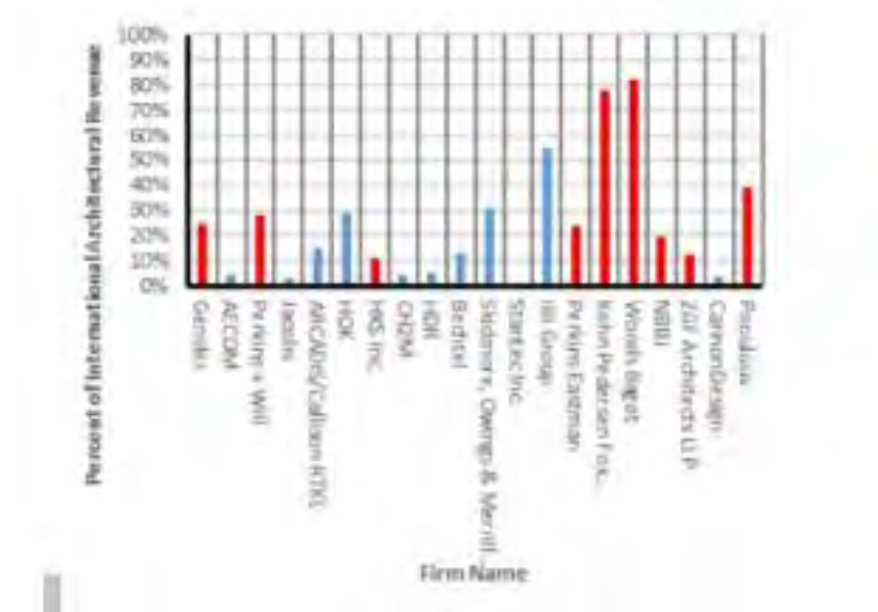
Figure 5. Percent of International Revenue of Architectural